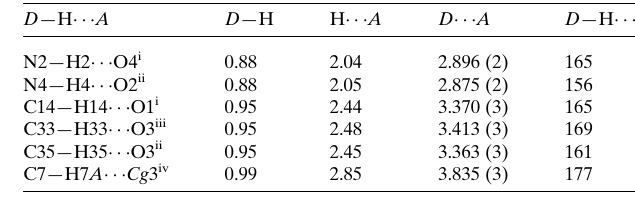
Table 1 Hydrogen-bond geometry (A˚ , (cid:2) ).